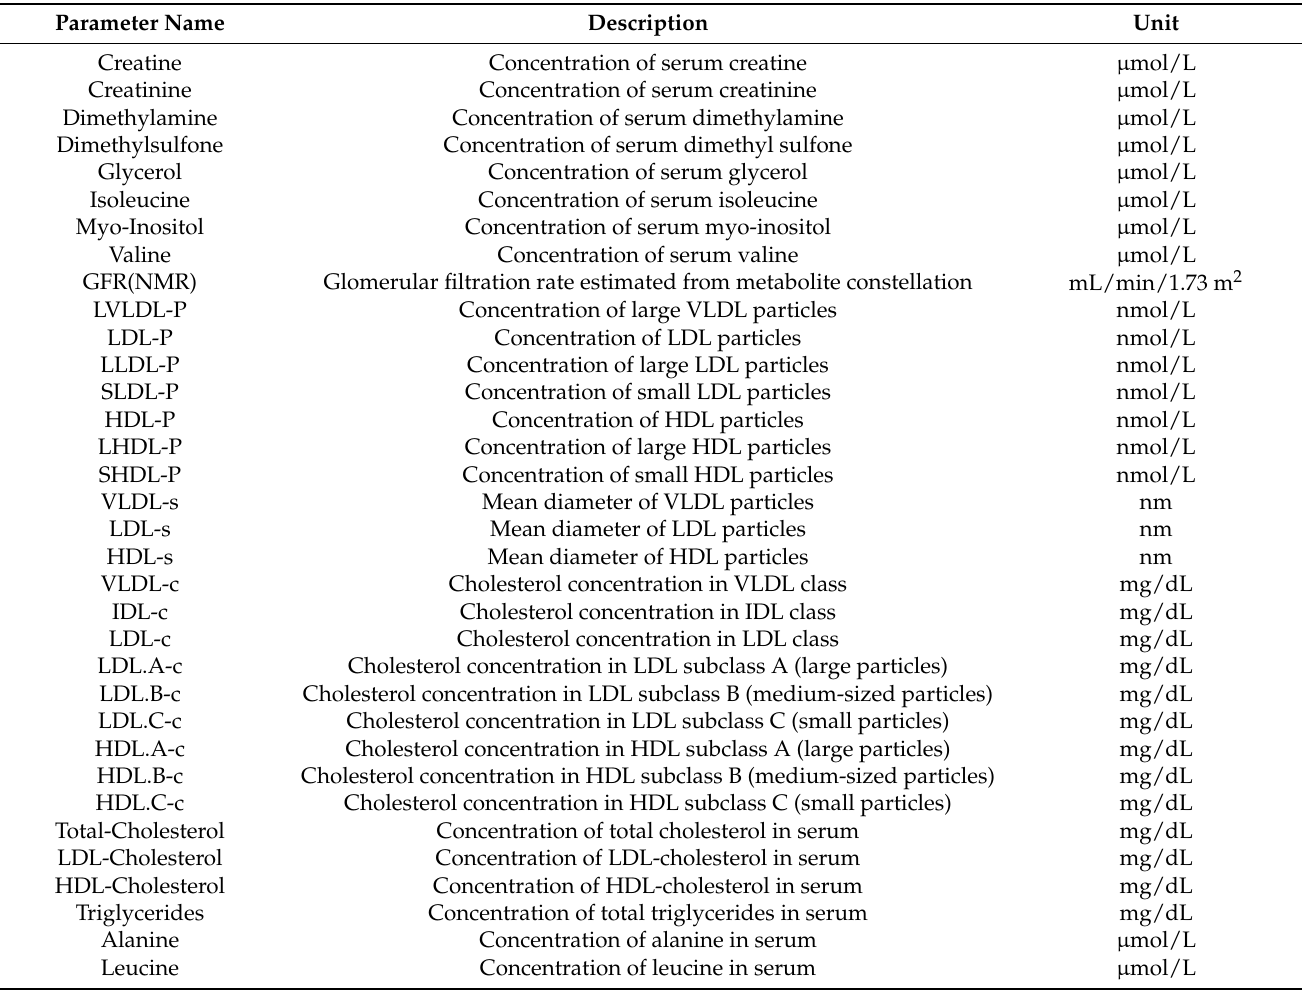
Table 1. Metabolite and lipid parameters that were analyzed in the present study using the standardized AXINON ® platform (Numares AG, Regensburg,